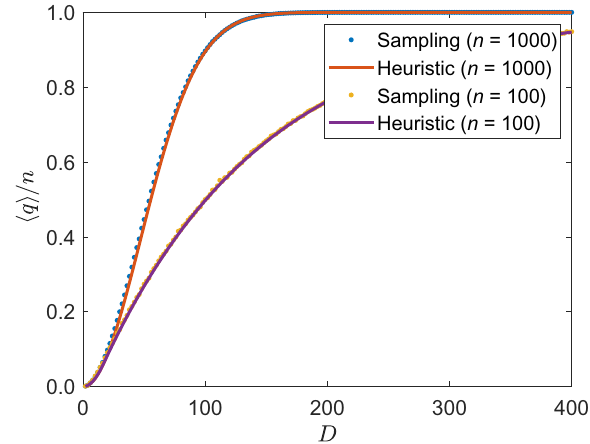
FIG. 5. The heuristic formula in Eq. (12) is plotted along with the results from sampling from the Markov chain for the 1D architecture. This is done for an error rate p = 10 − 3 and with two different system sizes, n = 100 and n = 1000. The heuris- tic formula shows good agreement with the result from sampling from the Markov chain. The number of samples taken is 50 000, and the error is upper bounded by